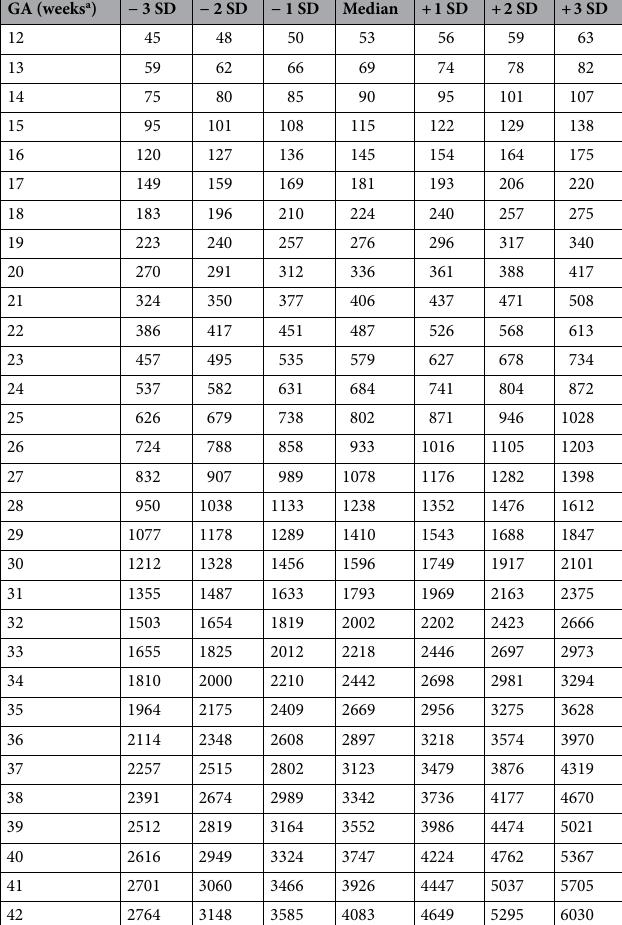
Table 2. Medians and standard deviations (SD) of estimated fetal weight in grams by gestational age (GA) for male and female fetuses. a GA expressed as completed gestational weeks, e.g. 12 weeks corresponds to 12 + 0 weeks or 84 gestational